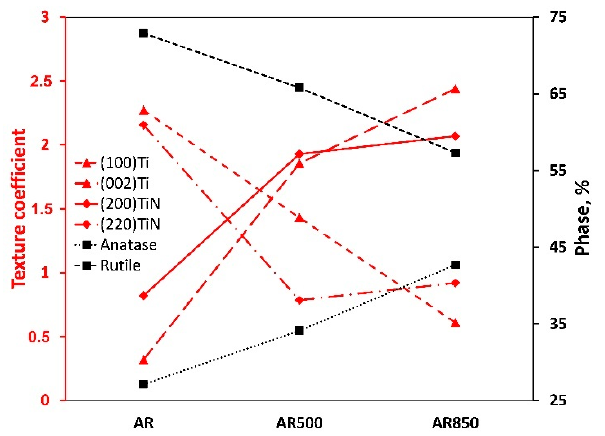
Figure 7. Texture coefficients of (100)Ti, (002)Ti, (200)TiN, (220)TiN, anatase, and rutile phase percentage in AR, AR500, and AR850.